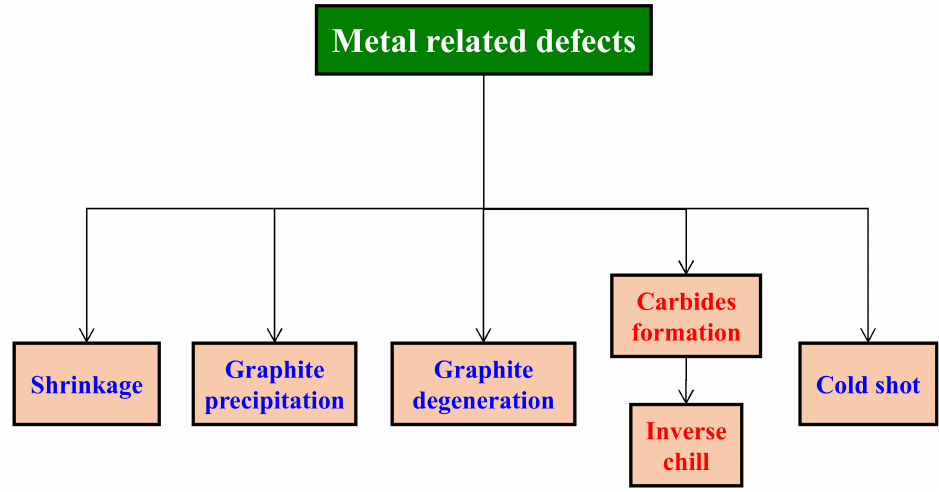
Figure 67. Classification of defects mostly related to cast